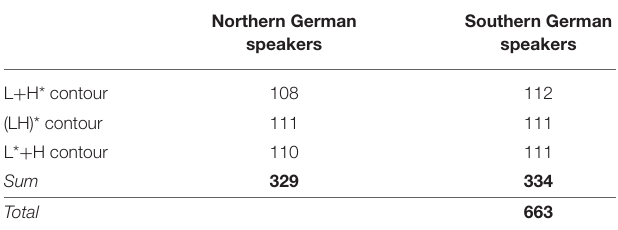
TABLE 2 | Overview of imitated productions per group in final dataset of Experiment